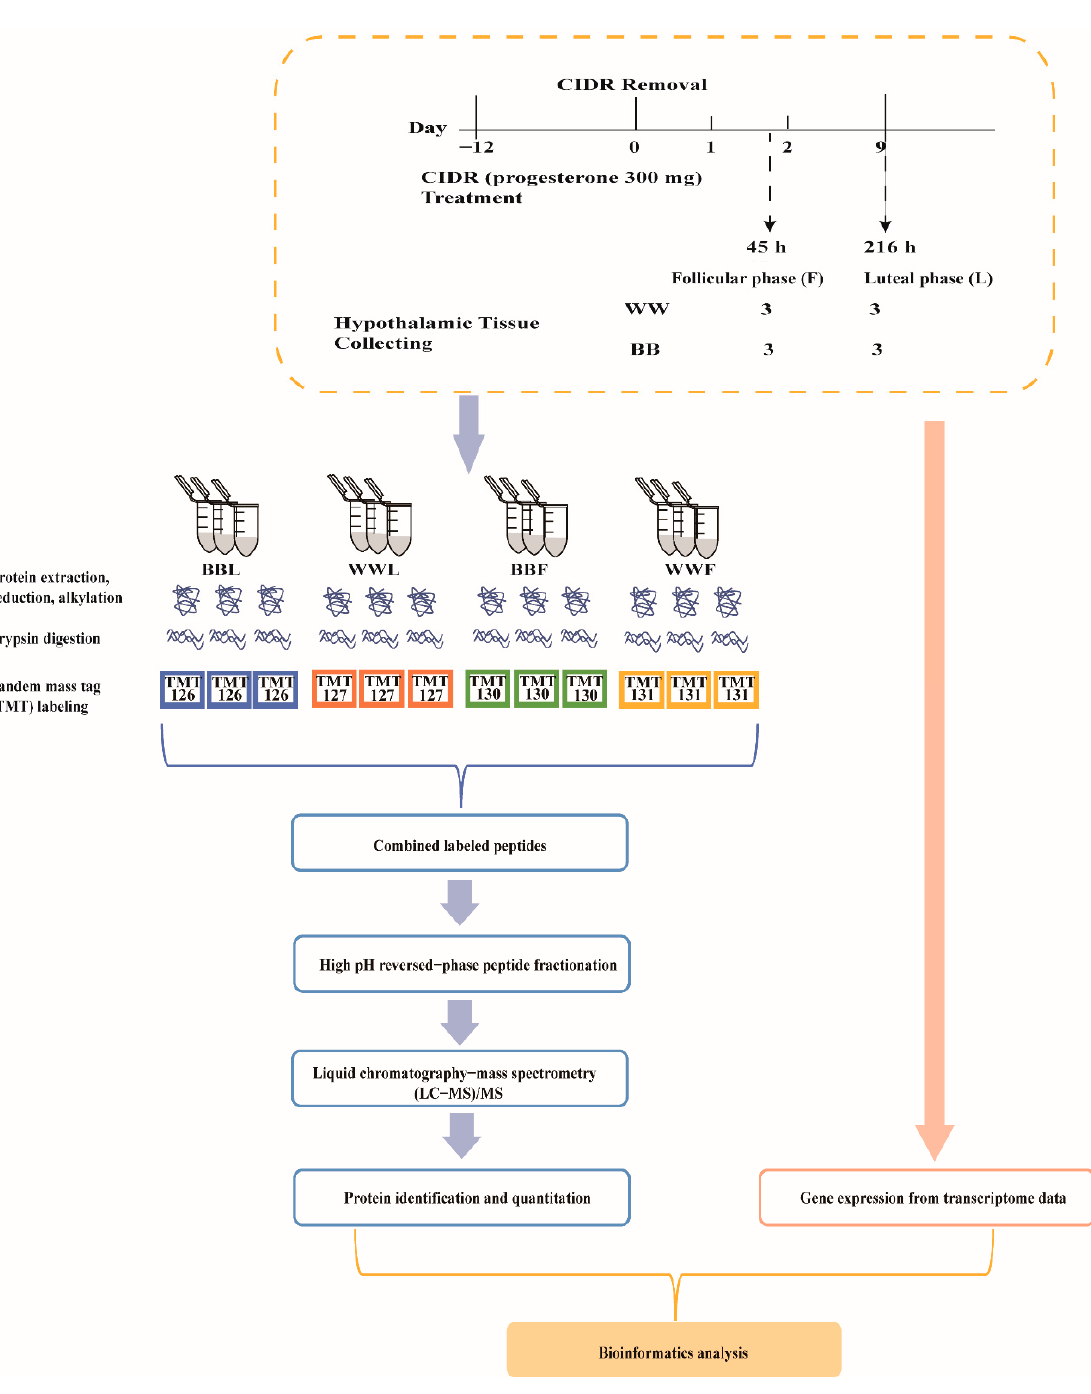
Figure 1. Sample grouping information overview of processing. Based on FecB genotypes, six STH ewes with the wild genotype (WW) and six FecB mutant homozygous (BB) were treated with con- trolled internal drug release (CIDR). After 12 days, the CIDR was removed from the ewes while the CIDR withdrawal time was recorded as 0 h. Hypothalamus tissue was collected from three WW ewes and three BB ewes euthanized at 45 h (follicular phase) (WWF, BBF). Subsequently, from three WW ewes and three BB ewes euthanized at 216 h (luteal phase) (WWL, BBL). The TMT quantitative proteomics analysis was employed to identify changes in the abundance of protein in hypothalamus tissues. Finally, bioinformatics analysis was performed in combination with downloaded tran- scriptomic data from the same samples.